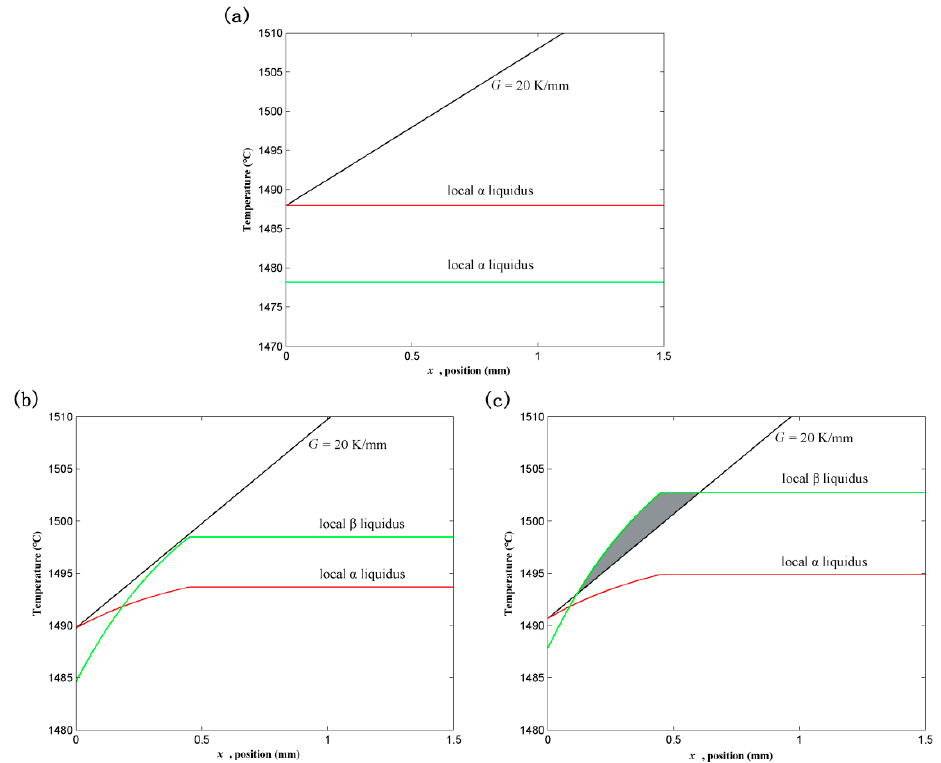
Figure 7. Local temperature and local liquidus temperatures of α and β and the constitutional undercooling with respect to β when the growth length is 0 mm ( a ), 50 mm ( b ) and 100 mm ( c ) during the quasi-seeding process.